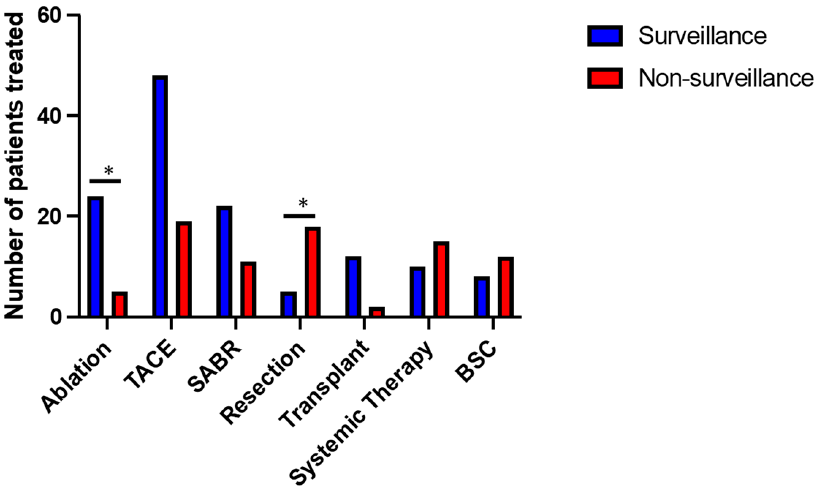
Figure 4. Overview of different treatments received in surveillance and non-surveillance groups. TACE (transarterial chemoembolisation), SABR (stereotactic ablative radiotherapy), BSC (best sup- portive care). * p < 0.05 (chi-square test).